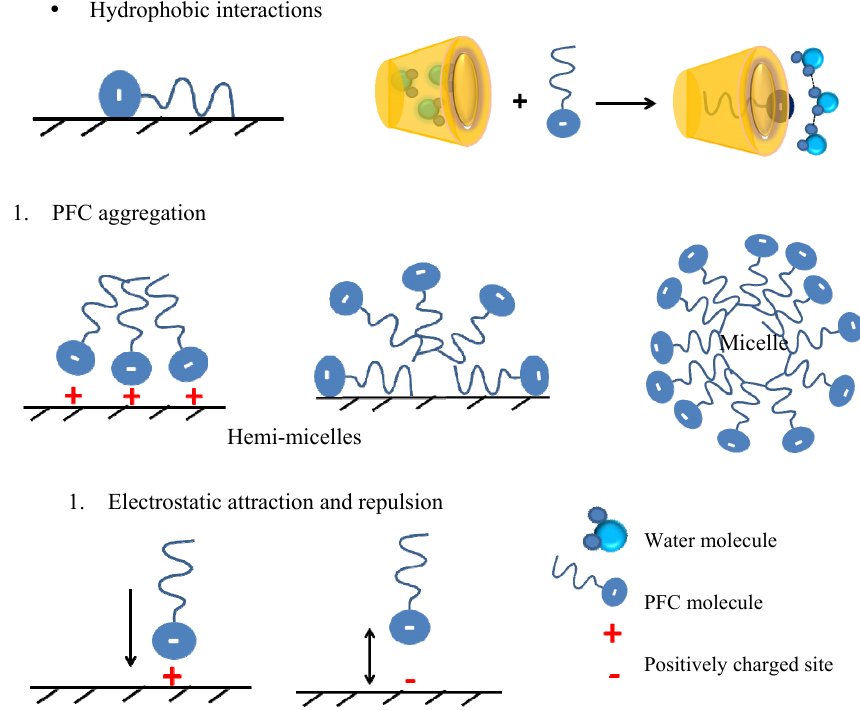
Figure 5. Schematic representation for ( a ) hydrophobic interactions; ( b ) PFC aggregation; and (c) electrostatic interactions (redrawn from